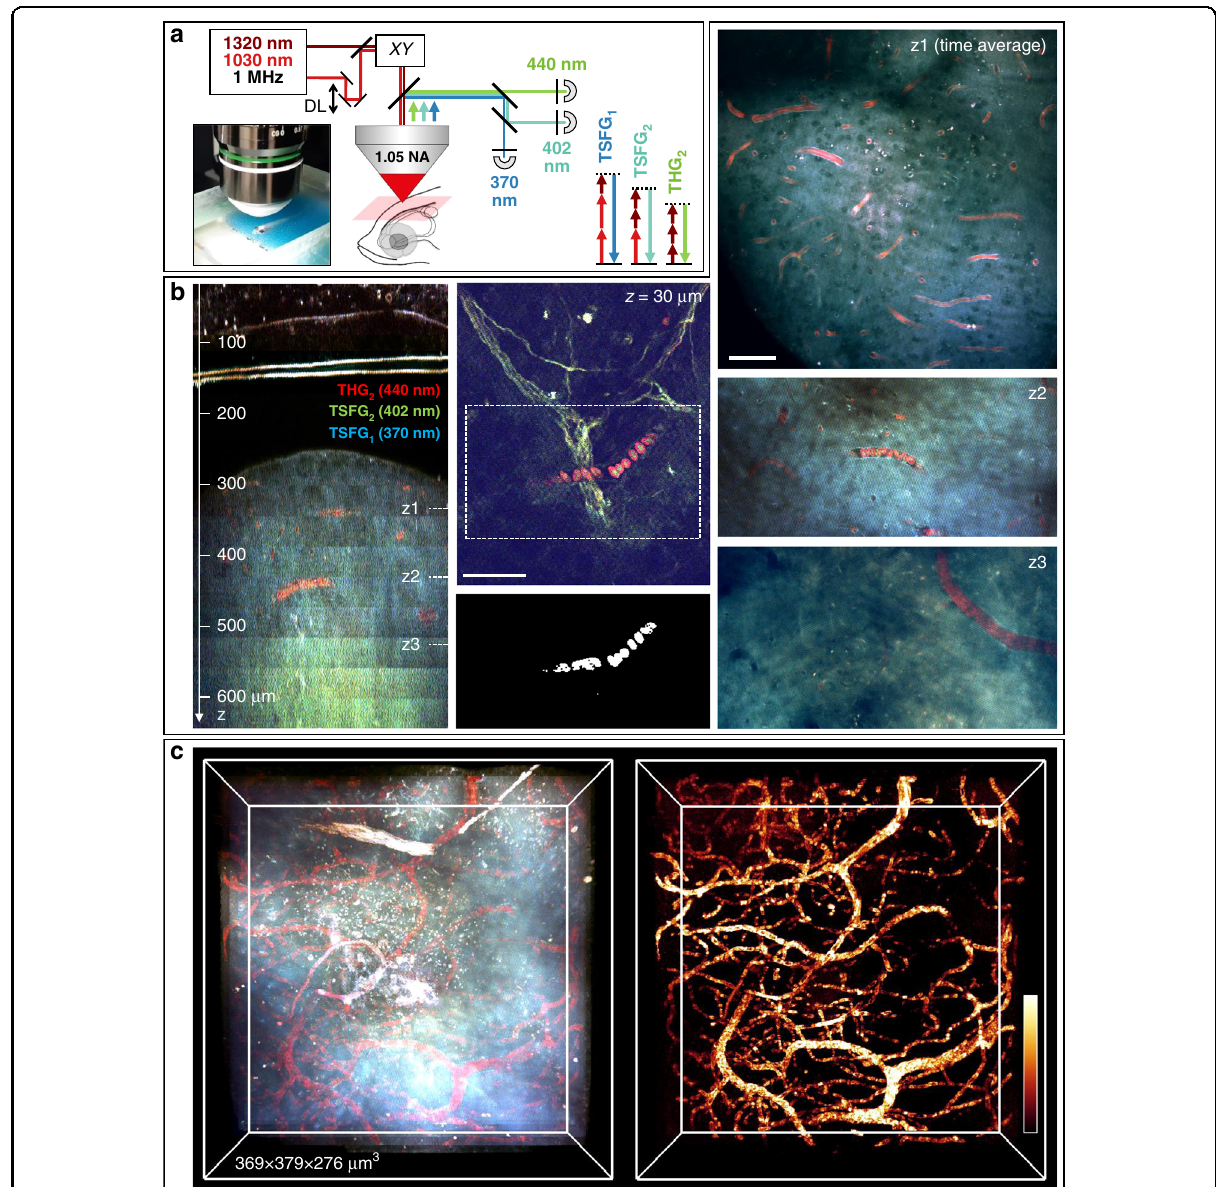
Fig. 5 Deep-tissue TSFG imaging in live adult zebra fi sh brain. a TSFG microscopy setup scheme for deep tissue imaging with 1 MHz excitation and signal epi-detection. b (left) XZ reslice calculated from a color TSFG z-series spanning >600 μ m of imaging depth through the skin, skull and telencephalon of an adult fi sh. (middle) Sub-skin image showing different spectral signatures for RBCs (in red) and myelinated axons. Segmented RBCs are shown below the image. (Right) Representative images recorded at several depths in the telencephalon, illustrating the speci fi c TSFG contrast of RBCs and vessels. c 3D rendering of the imaged volume in the telencephalon and of the segmented blood vessels. Scale bar: 50 μ m. See also Movies M7 –